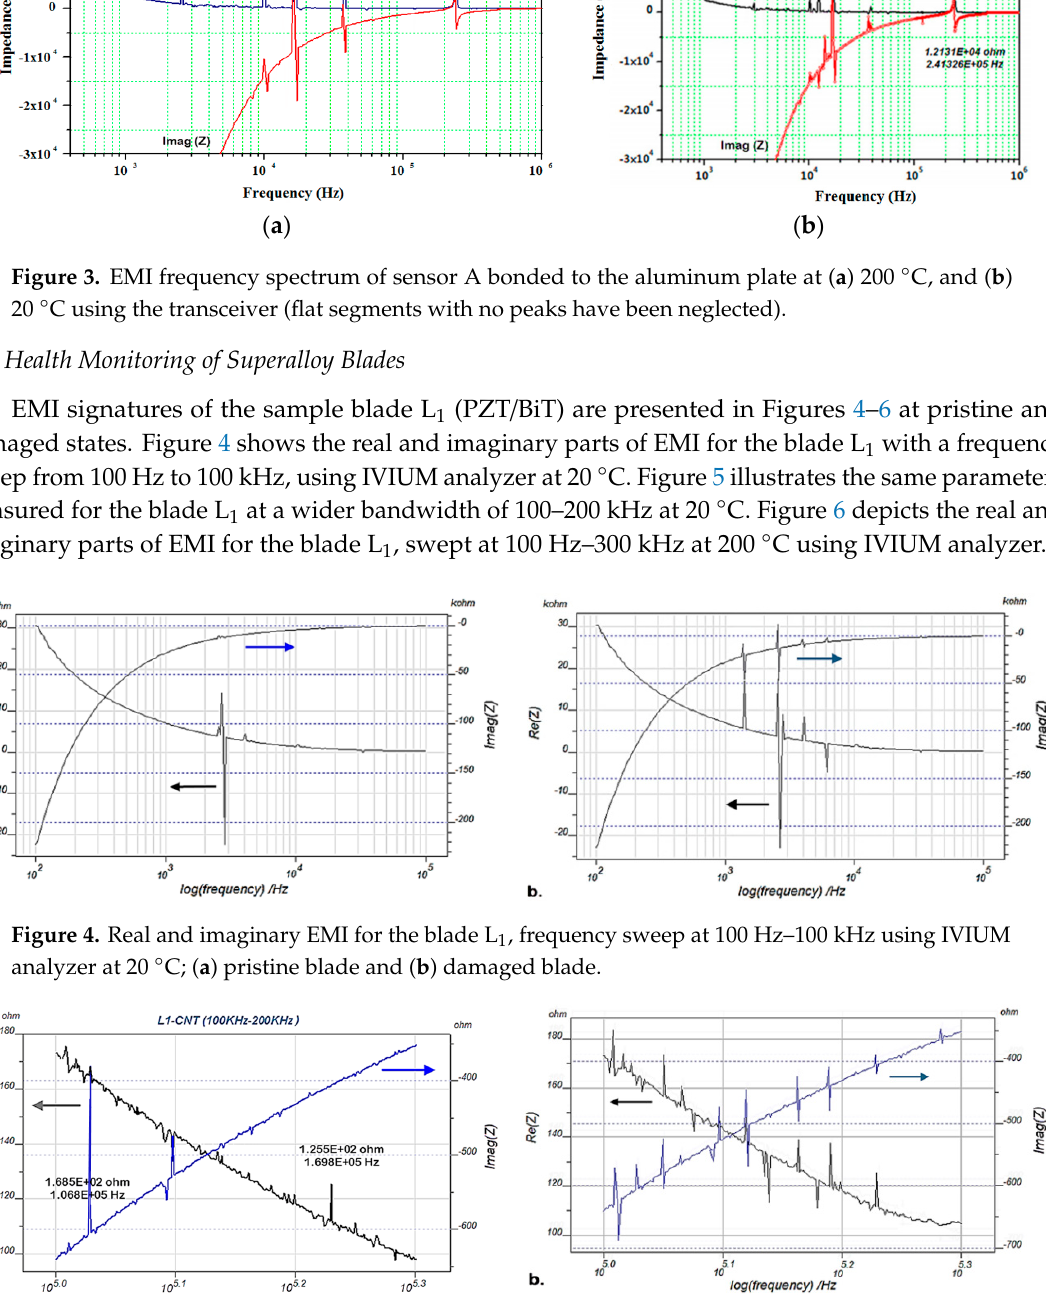
Figure 5. Real and imaginary EMI for the blade L 1 , frequency sweep at 100–200 kHz using IVIUM analyzer at 20 °C; ( a ) pristine blade and ( b ) damaged blade.